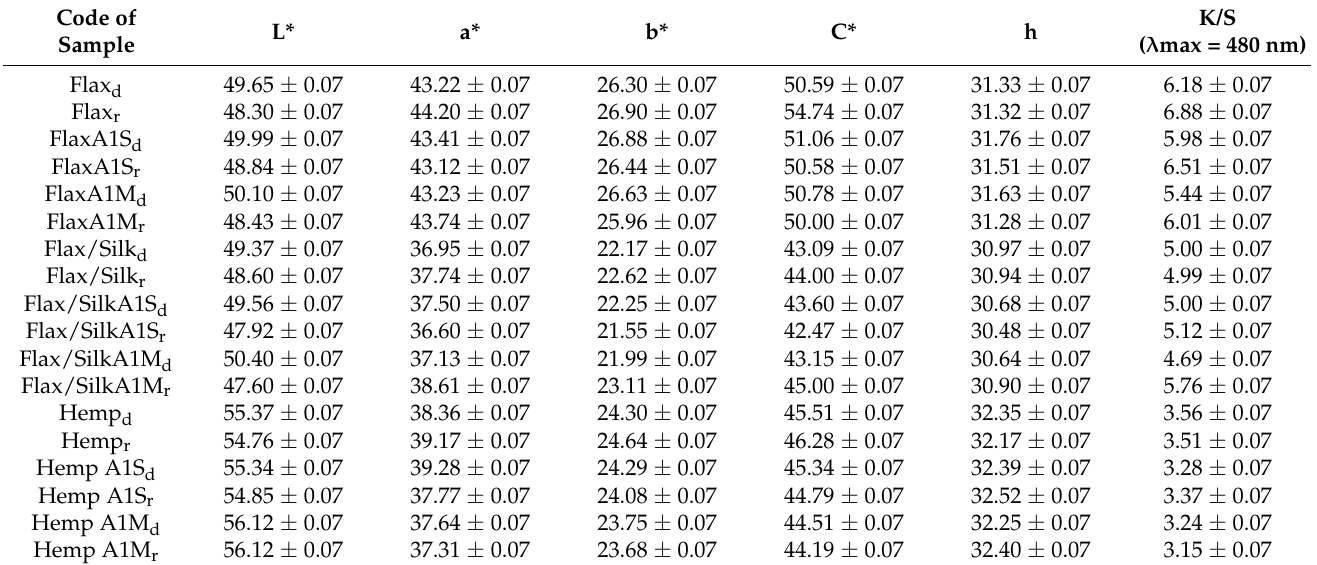
Table 2. The CIE L * a * b * colour coordinates and maximum K / S values of dyed unwashed and washed fabrics. Code